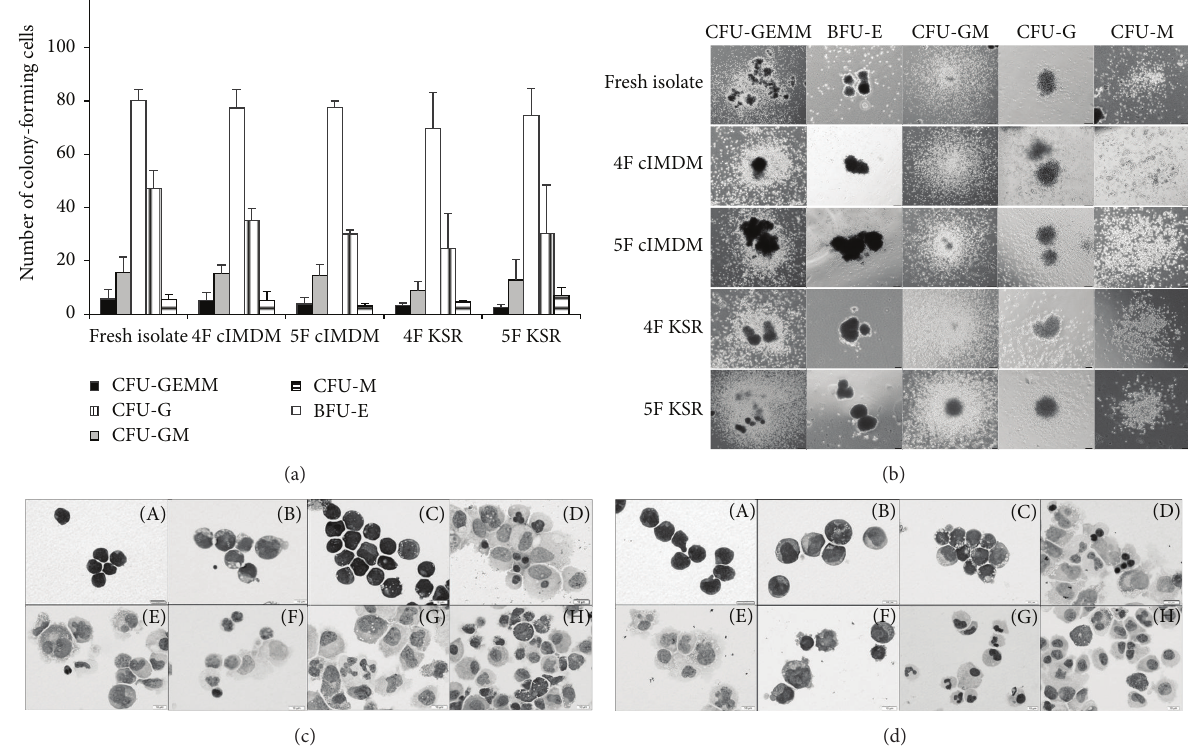
Figure 4: Hematopoietic colony-forming units and differentiation capacity of expanded CB-CD34 + cells in vitro . (a) Colony-forming assay of 5-day-enriched CB-CD34 + cells in 4 different culture conditions (mean ± SD; 𝑛 = 3 ). (b) Photographs of CFU-GEMM, CFU-GM, BFU-E, CFU-G, and CFU-M after incubated in methylcellulose for 14 days. Liquid differentiation assay of 5-day-expanded CB-CD34 + cells from (c) 4F KSR and (d) 5F KSR conditions. In (c) and (d), (A) fresh CB-CD34 + cells, (B) 5-day-expanded CB-CD34 + cells, (C) 7-day-expanded CB-CD34 + cells, (D) erythroid lineage differentiation (EPO+SCF), (E) megakaryocytes differentiation (TPO+SCF), (F) lymphoid lineage differentiation (IL-7, Flt3-L, SCF+OP9), (G) granulocytes and macrophage lineages differentiation (GM-CSF+IL-3), and (H) mast cells and granulocyte lineages differentiation (SCF+IL-3). Bar correspondences as 10 𝜇